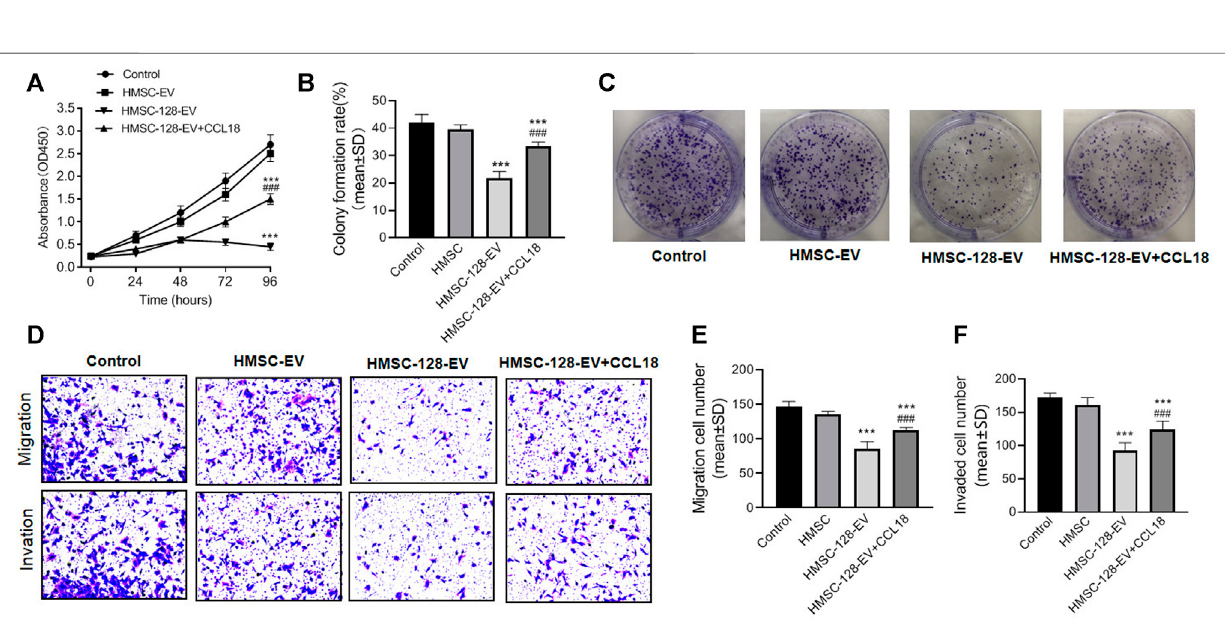
Frontiers in Molecular Biosciences |